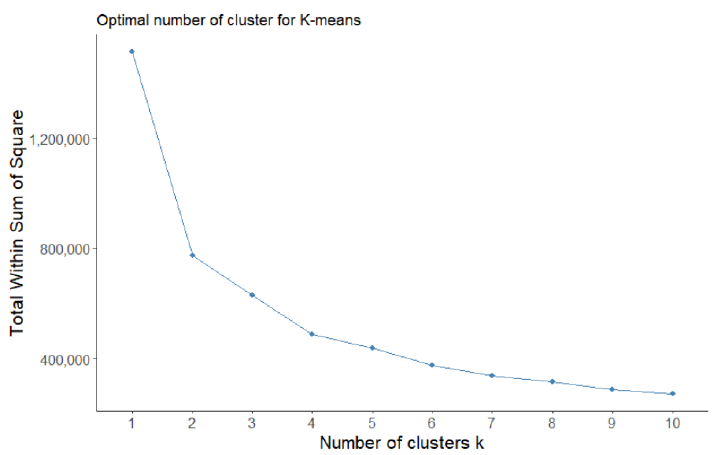
Figure 3. Elbow method on the selected variables using k-means clustering. Three- and four-cluster analyses were performed.